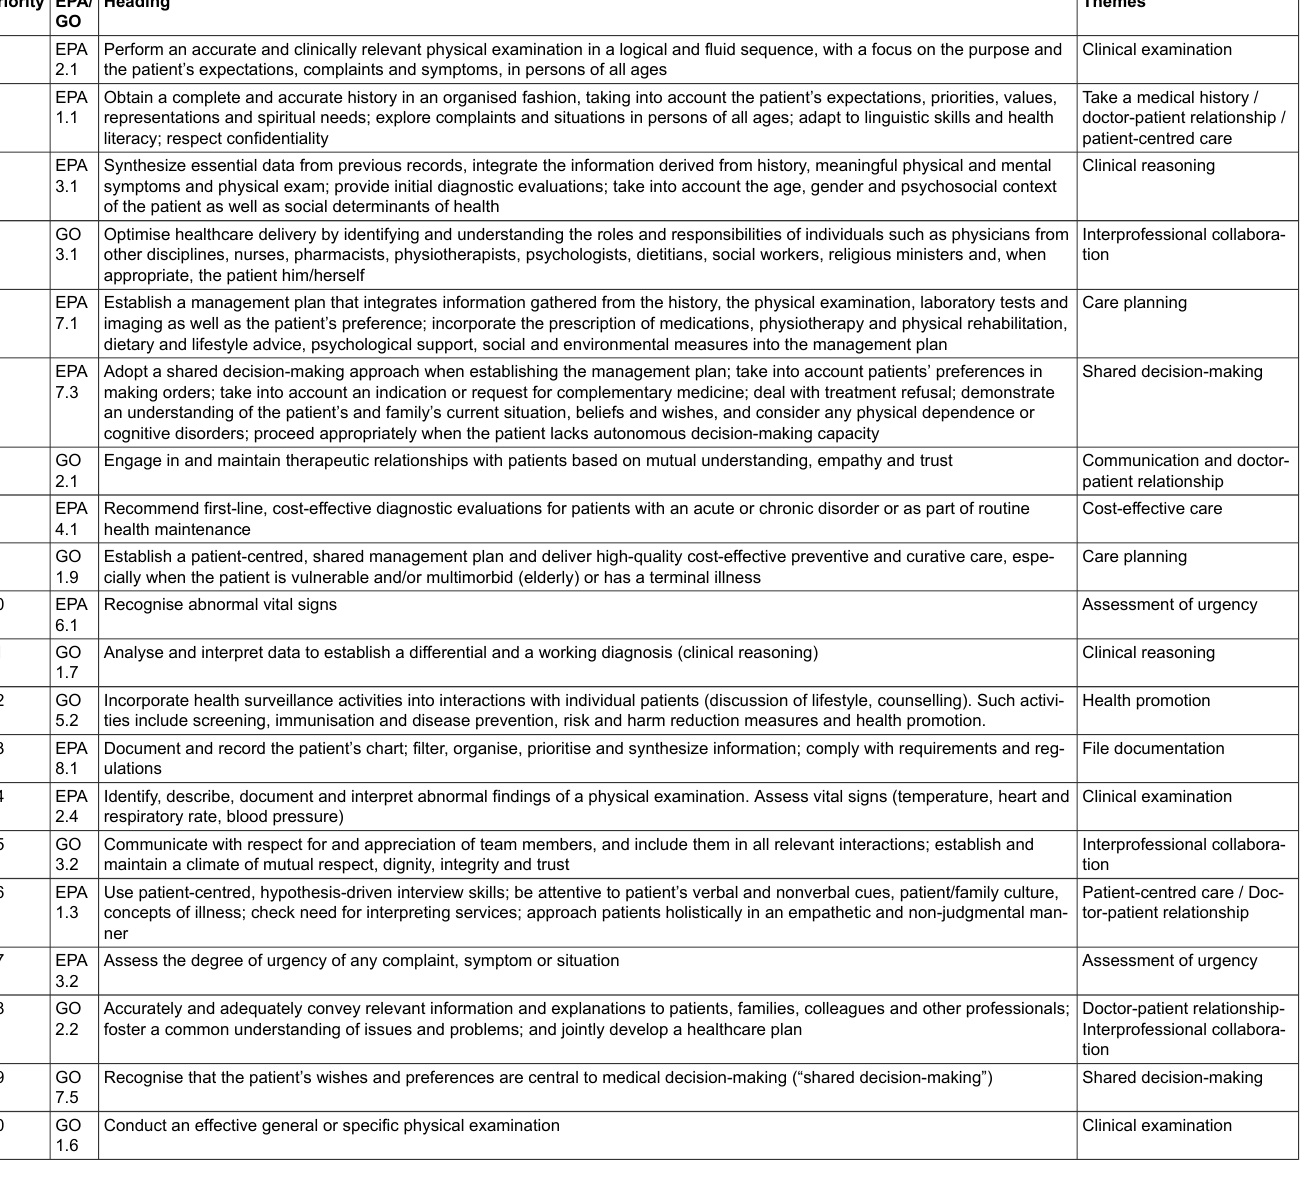
Table 3: Priority objectives for family medicine education based on expert consensus using the modified Delphi method. Priority EPA/ GO